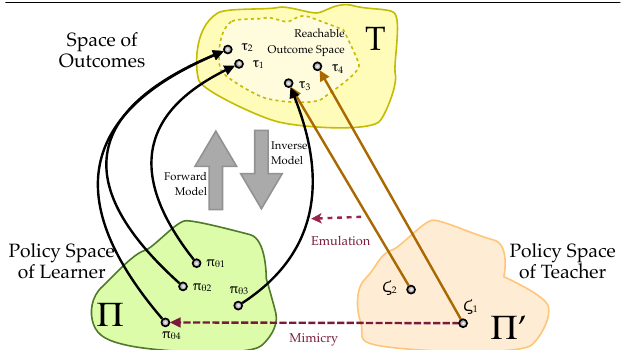
Figure 2. Representation of the problem. The environment can evolve to an outcomestate τ bymeansofthelearner’spolicyofparameter θ orthe teacher’sactions ζ . Thelearnerandtheteacherhaveaprioridi(cid:636)erent policy spaces. The learner estimates L − 1 : T 7→ Π . By emulation or mimicry, the learner can take advantage of the demonstrations ( ζ , τ d ) of the teacher to improve its estimation L − 1 . For the tennis player, the policy controls the movement of his arm and racket and M represents the physical equations for the ball trajectory. The performance of a policy π θ at completing an outcome τ is